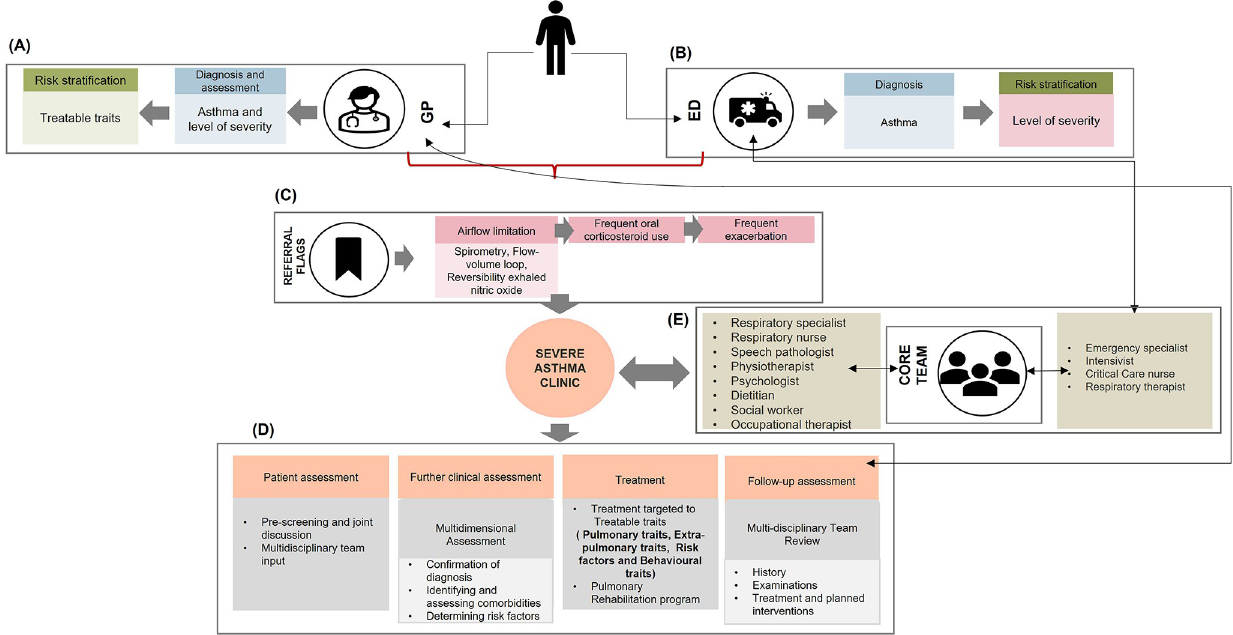
Fig 3. HCPs’ proposed care pathways in severe asthma. (A) GP pathway, (B) ED pathway, (C) Referral criteria to specialist care, (D) Multidimensional assessment and individualised management, (E) MDT involved in severe asthma care. GP = general practitioner; ED = emergency department; MDT = multidisciplinary